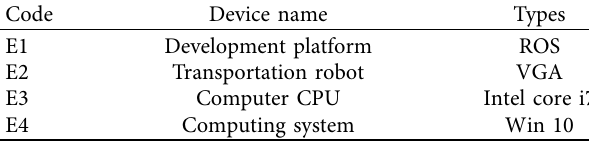
Table 1: Related equipment for simulation experiments.